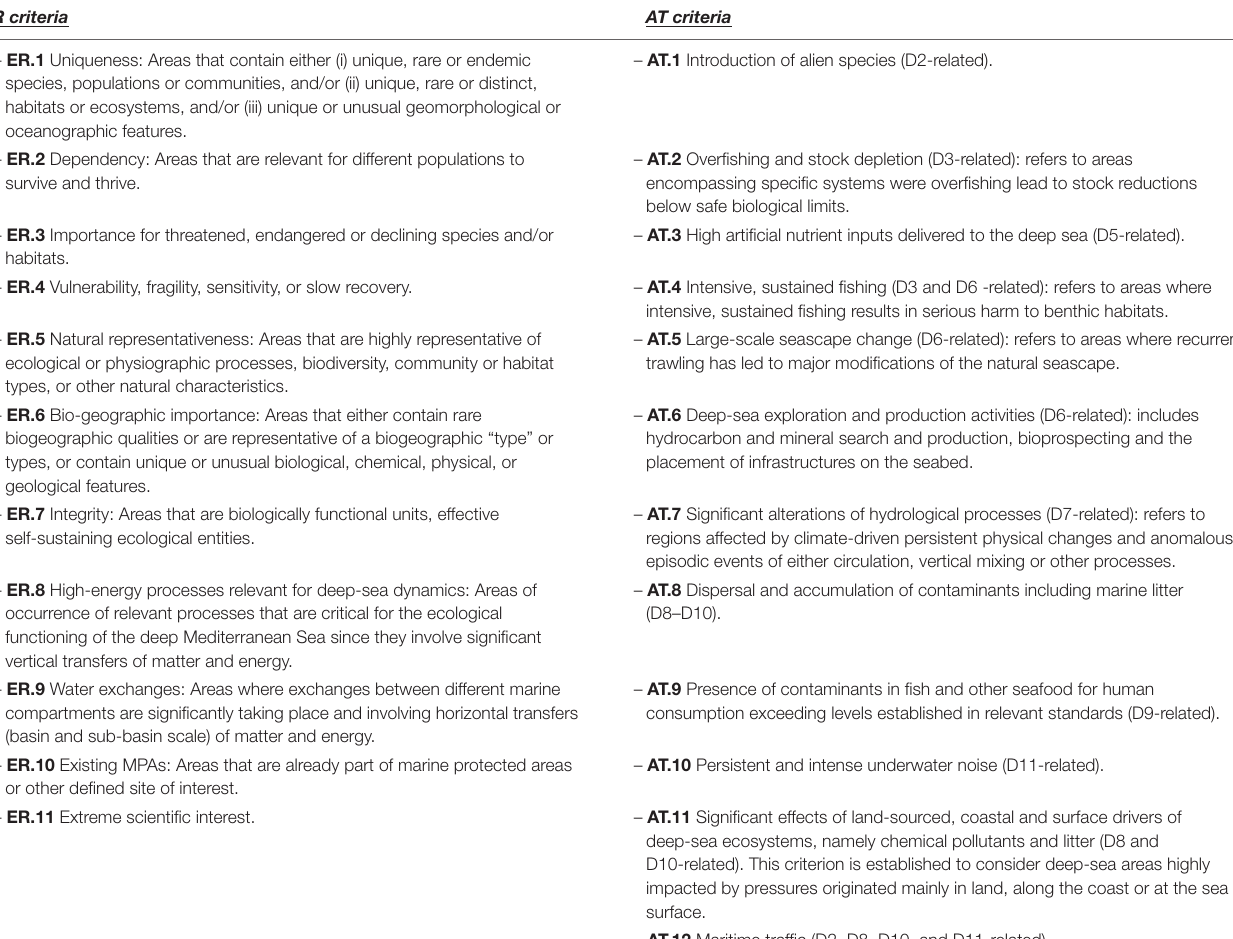
TABLE 3 | Description of ecological relevance (ER) and anthropogenic threats (AT) criteria used in the expert judgment. ER criteria AT